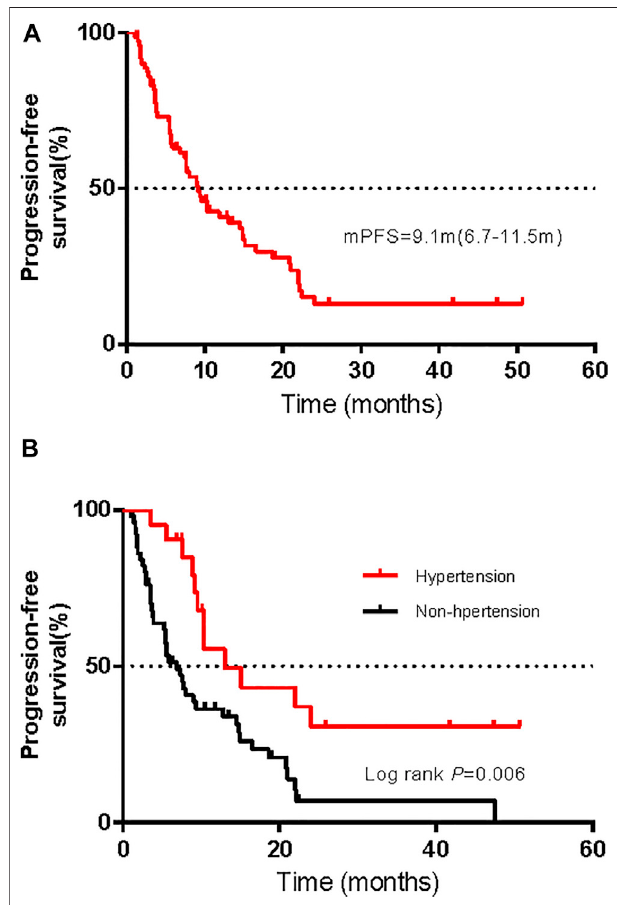
FIGURE5| Kaplan – Meiercurvesofprogression-freesurvival(PFS)forall patients (A) and comparison of PFS in patients with and without hypertension (B)